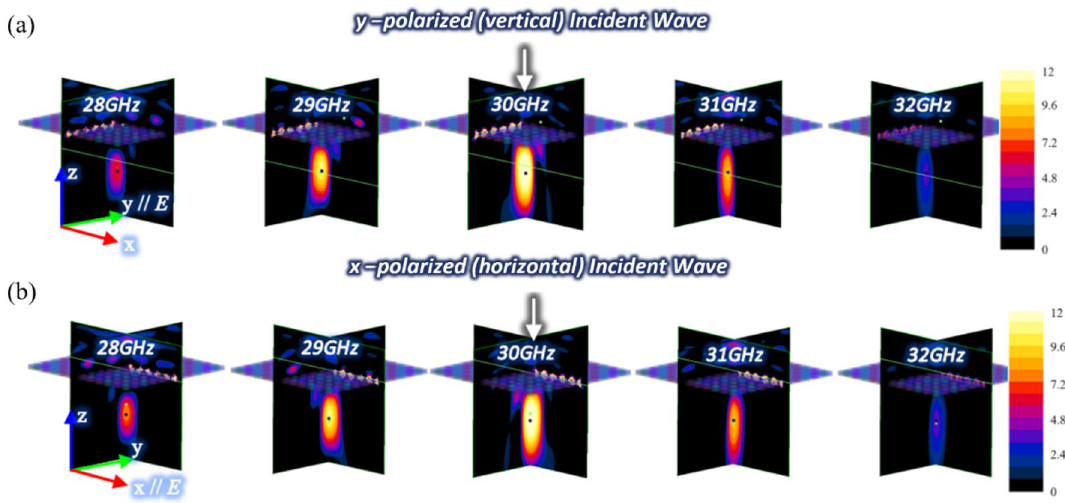
Figure 2. Simulated field intensity distribution for ( a ) y-polarized (vertical) and ( b ) x-polarized (horizontal) incident plane waves at various